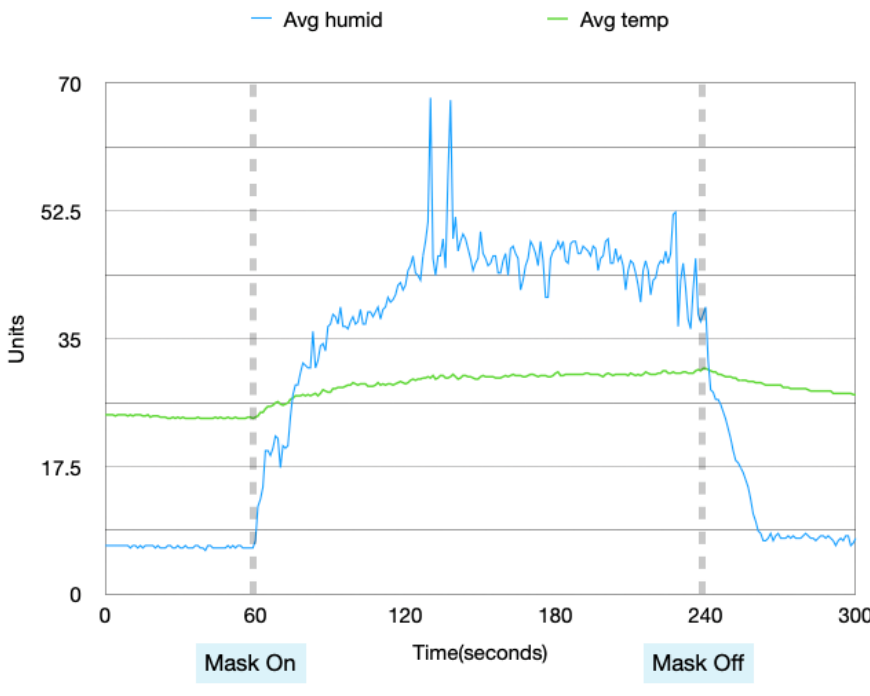
Figure 5. Data collected during the night, with no prior physical